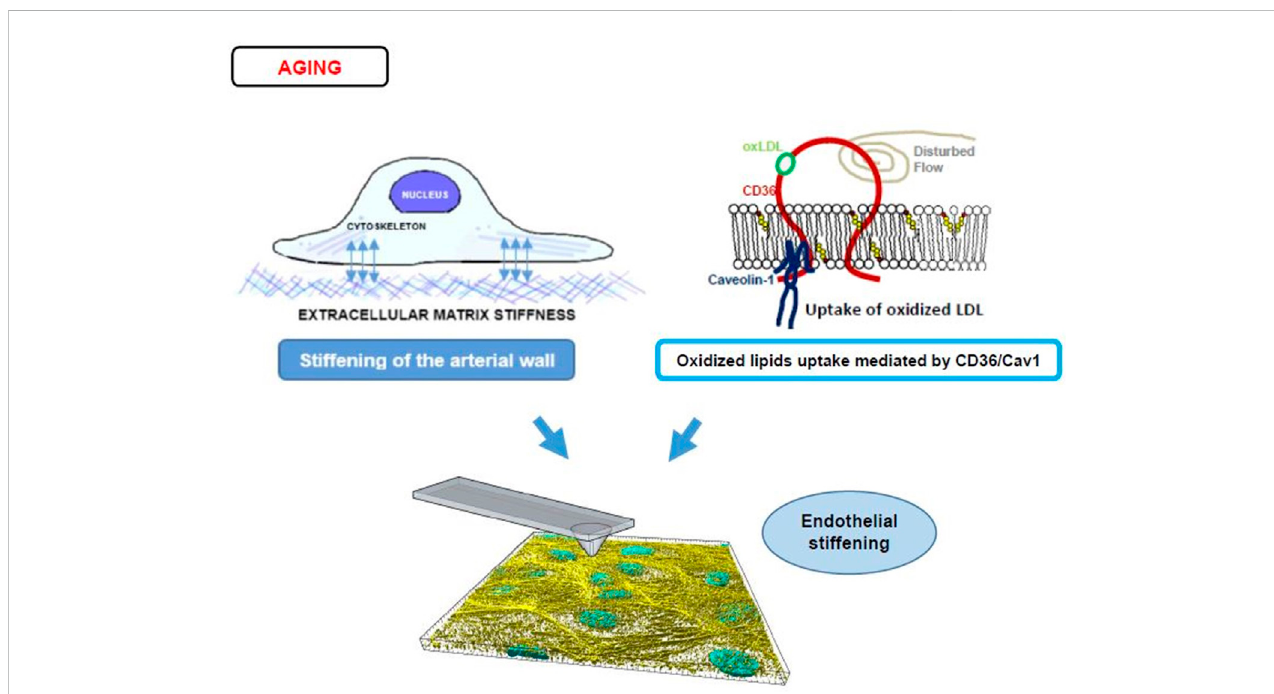
Endothelial stiffening and aging. The top left panel displays a diagram of an endothelial cell ’ s mechanotransduction process from the ECM (depicted as short crosslines outside of the basal side of a cell) to the focal adhesions/integrins (blue double-sided arrows) to cytoskeletal networks (intracellular light purple bundles). For a stiffer arterial wall and therefore stiffer ECM, this mechanotransduction leads to more F-actin stress fi ber activity and stiffer cells. The right top panel displays an alternate process of stiffening caused by disturbed fl ow and CD36/Cav1 mediated uptake of oxLDL (CD36 is shown schematically as a red integral protein, that is bound to Caveolin-1 at the inner lea fl et of the membrane, shown in blue, oxLDL bound to CD36 is shown in green and oxysterols incorporated into the bilayer are shown in yellow/red). The bottom panel shows a 3D reconstructed image of the F-actin stress fi bers (yellow)andnuclei(blue)inanendothelialmonolayerbeingprobedbyanAFMtiptoobtainYoung ’ smodulusvalues.TheinterplaybetweenECMandoxLDLin the induction of endothelial stiffening is described in Section 5 of the